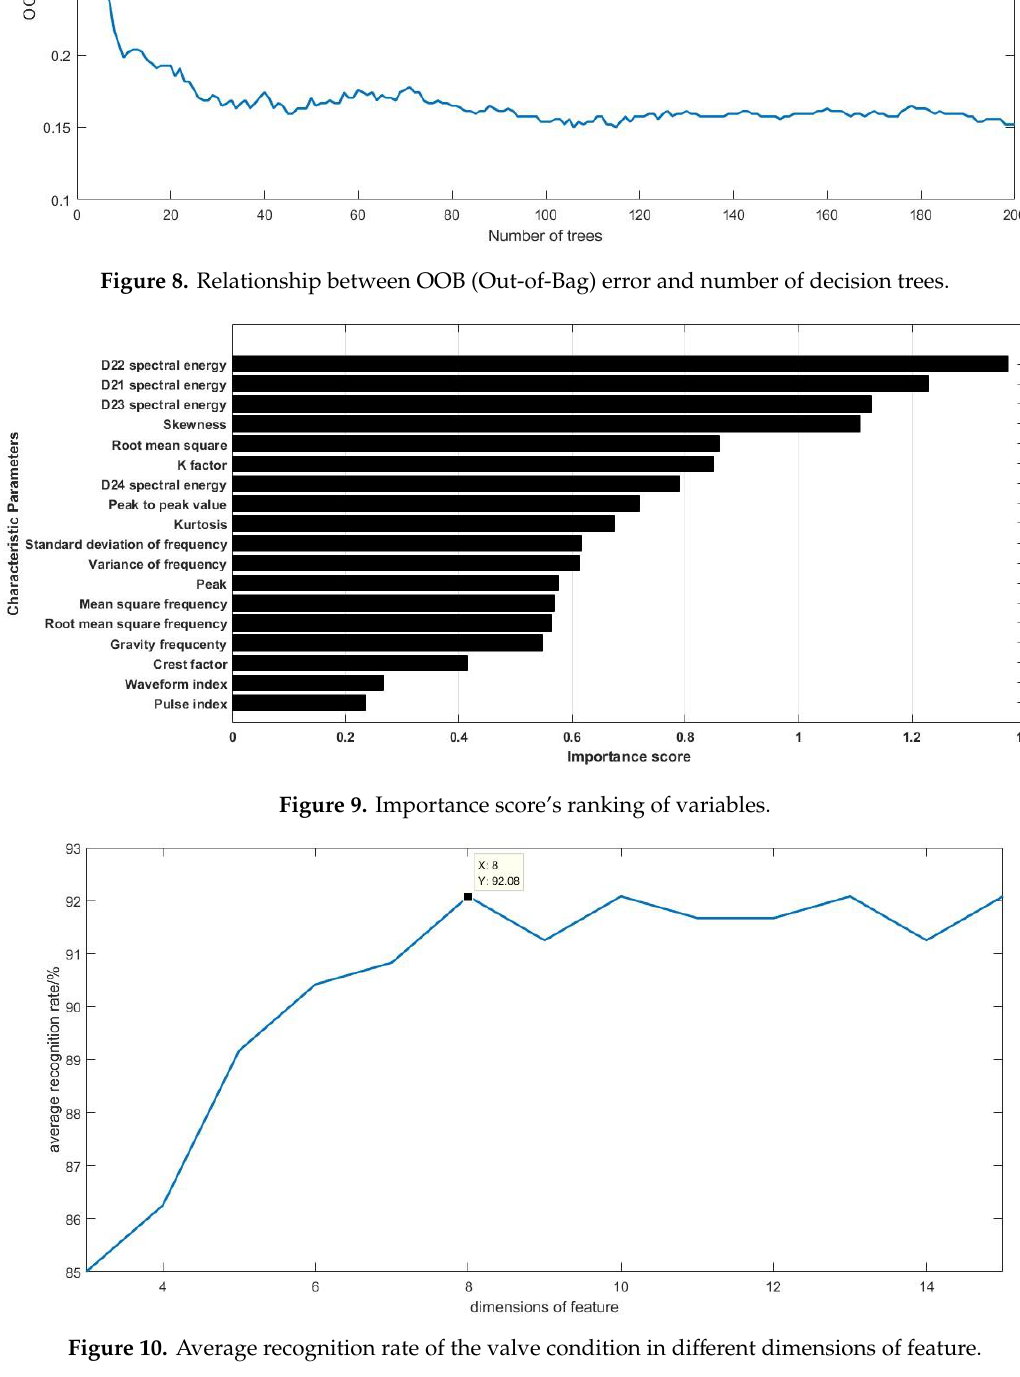
Figure 10. Average recognition rate of the valve condition in different dimensions of feature.